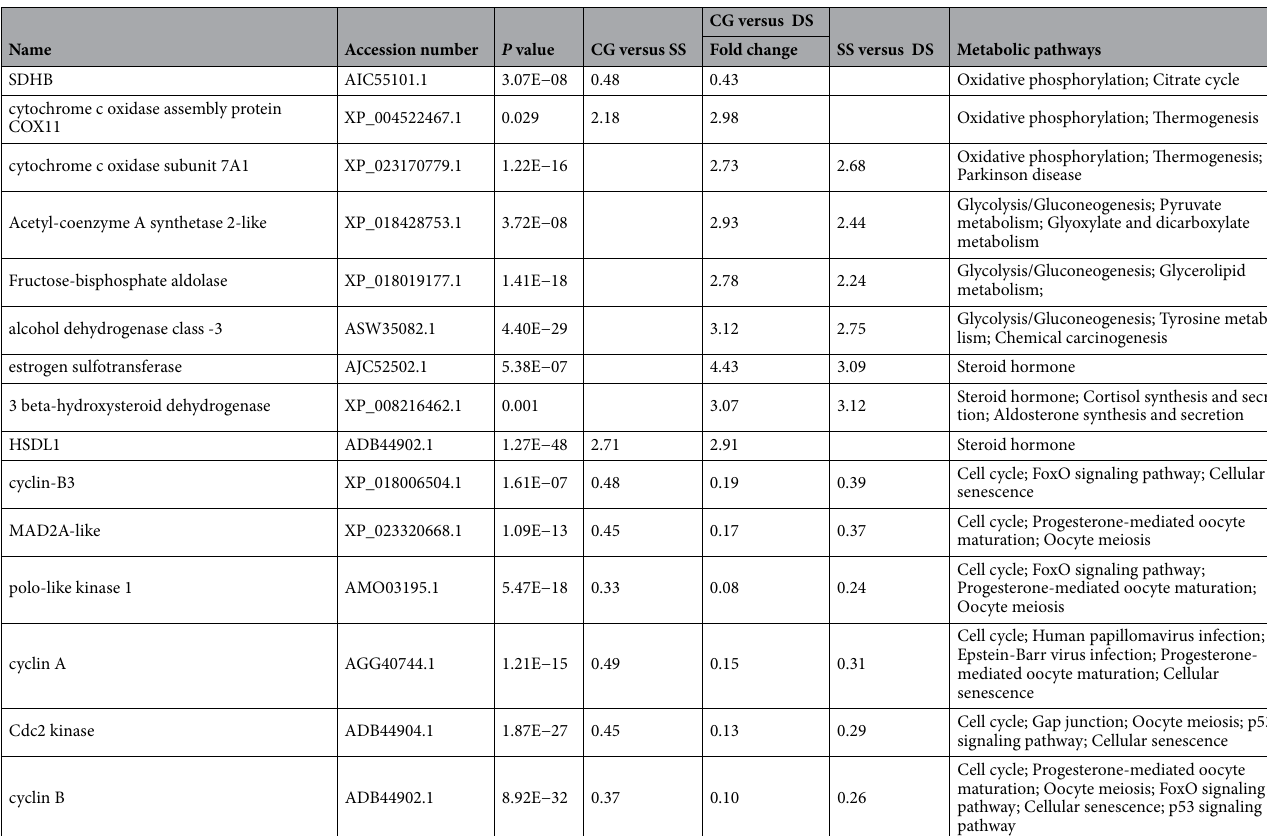
Table 1. Identification of important DEGs from transcriptome profiling